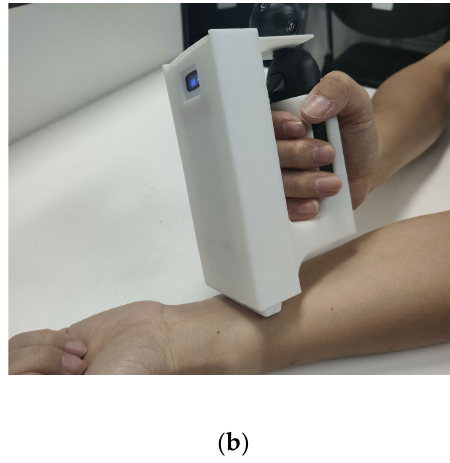
Figure 11. Ultrasound phantom and human tissue acquisition method. ( a ) Ultrasound phantom; ( b ) human